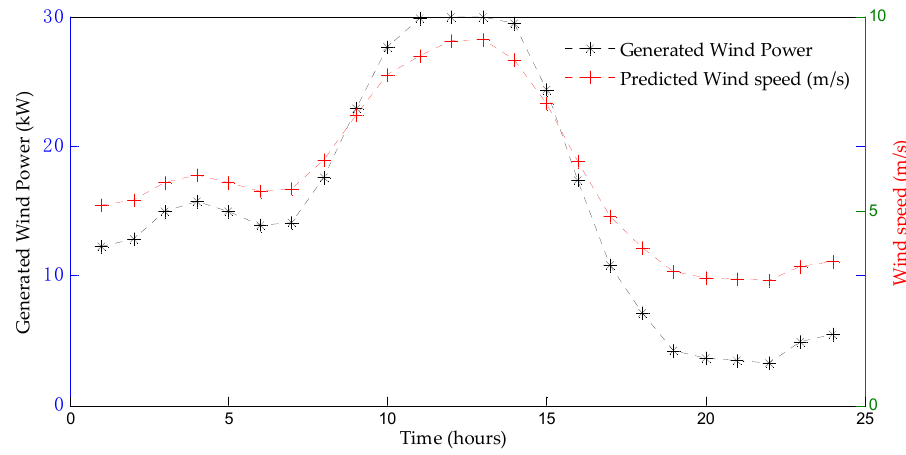
Figure 16. Predicted wind speed and approximated wind power.